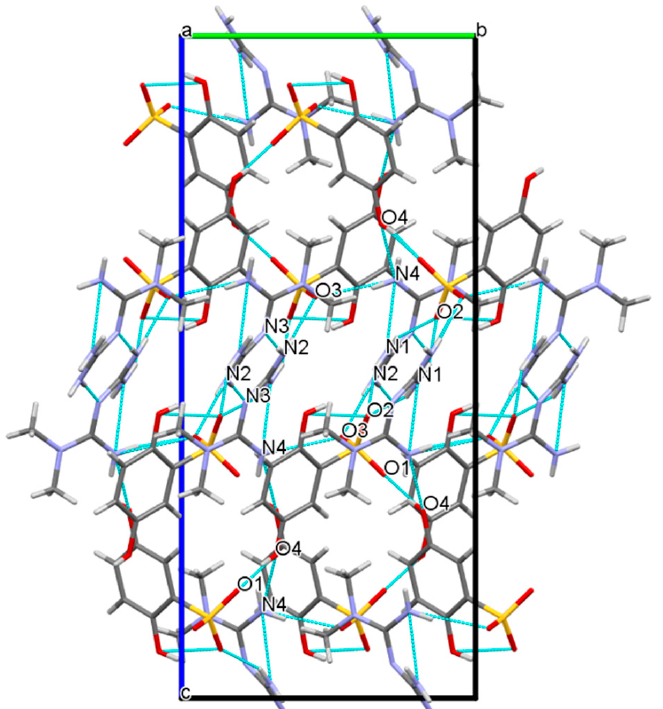
Figure 8. The 3D packing diagram connected by hydrogen bonds of MET–DBS viewed along the a